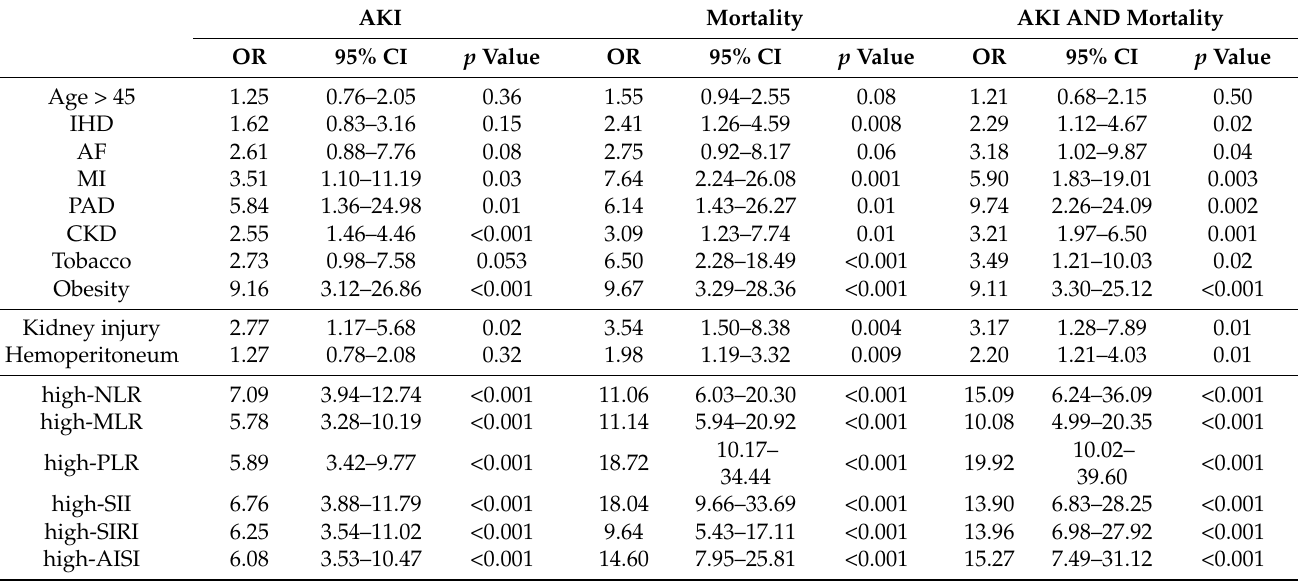
Table 4. Multivariate analysis of new adverse events occurred throughout the course of the research.